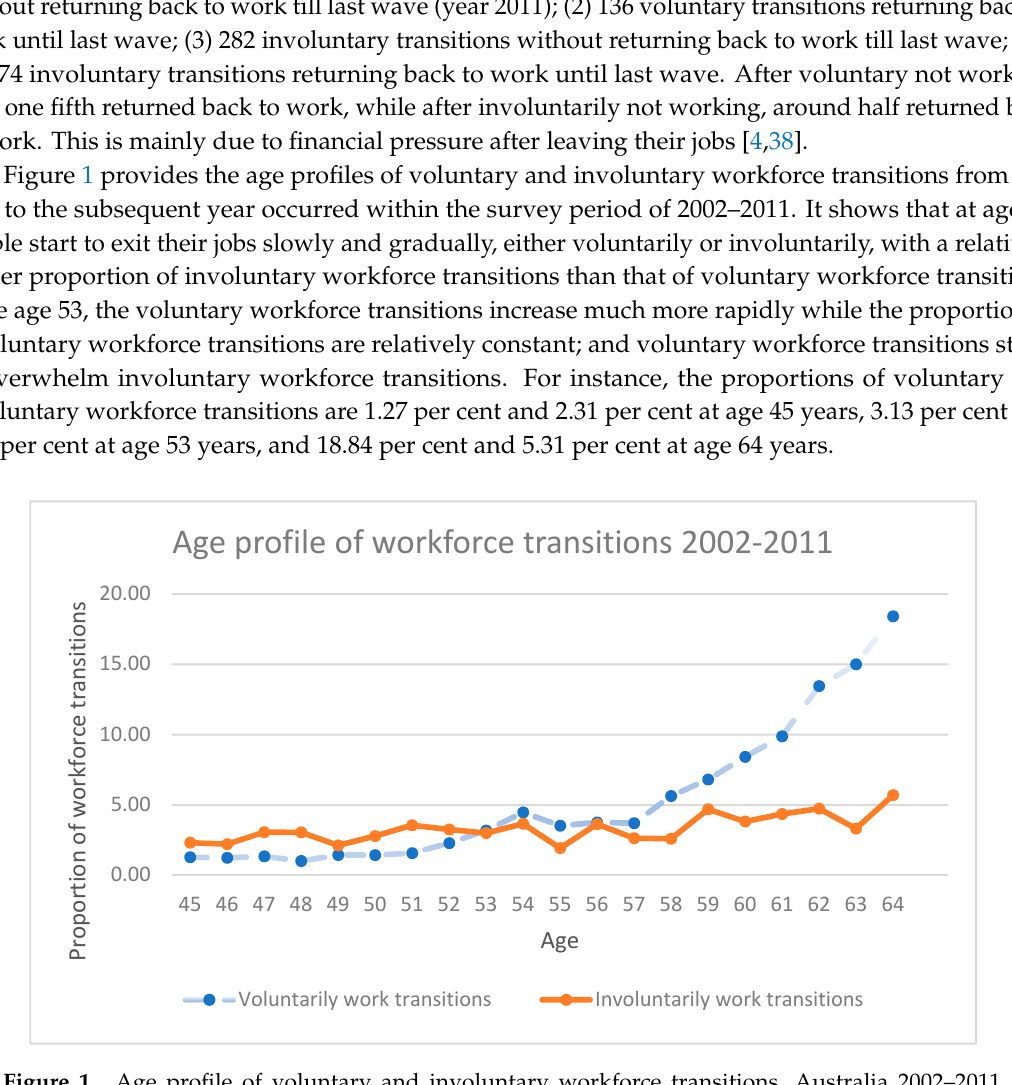
Figure 1. Age profile of voluntary and involuntary workforce transitions, Australia 2002–2011. Data source: Authors’ own calculation from the pooled data of HILDA survey 2002–2011.